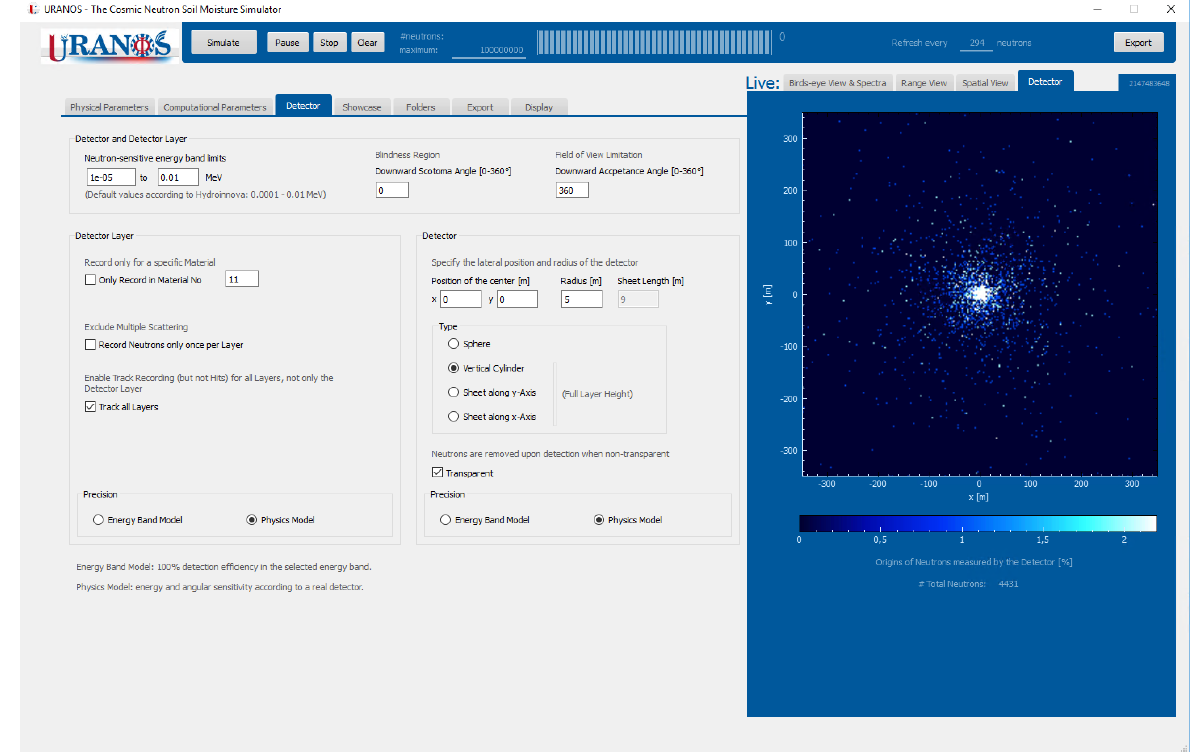
Figure 17. URANOS user interface showing the detector tabs. (left) Settings for changing energy and angular sensitivity, as well as geometric shape and extension. (right) Detector scoring output showing the origins of detected